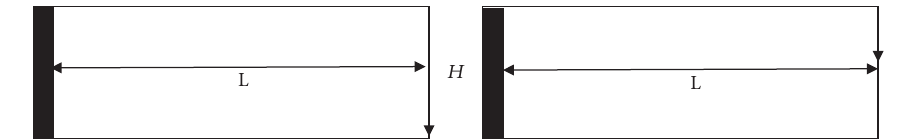
Figure 2: The initial structure domain of the MBB beam.